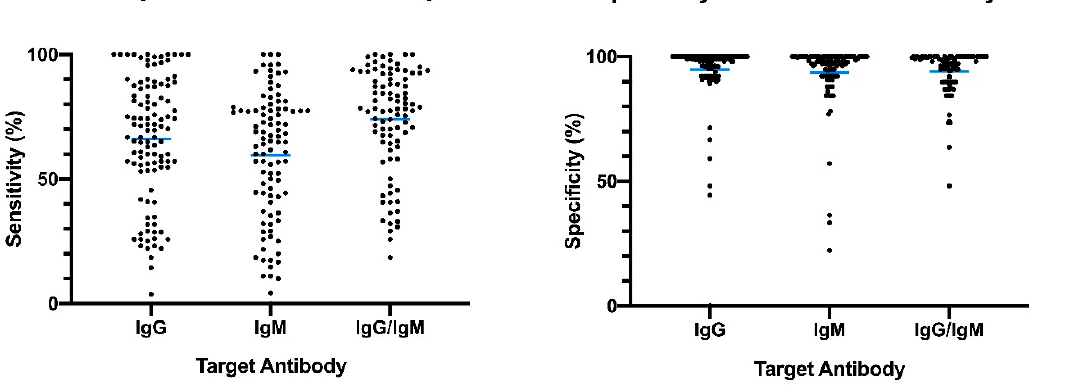
Figure 5. Overview of reported sensitivity and specificity of COVID-19 serological tests. Reported performance data from categories were plotted based on target antibody (IgG, IgM, IgG / IgM) to provide an overview of variability distribution in marketed diagnostic tests. Blue bars represent the mean values.